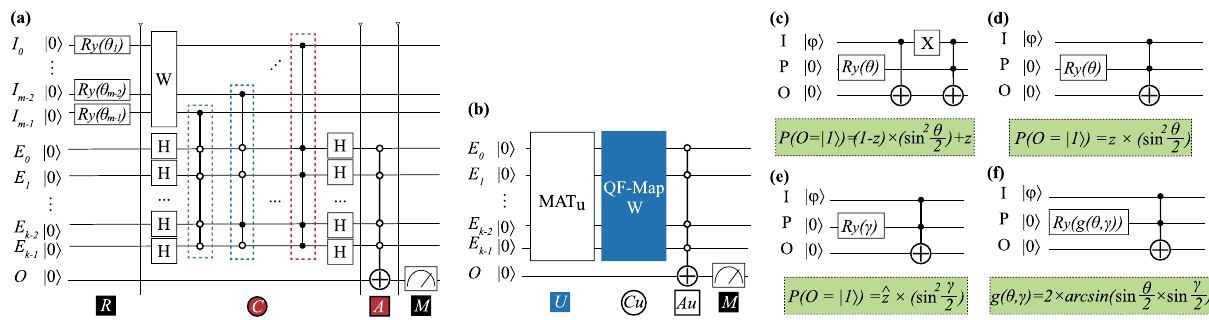
Fig. 6 The corresponding implementation of operations (e.g., R, C, A) in QF-Circ. a Quantum circuit designs for QF-pNet; b quantum circuit design for QF-hNet; c – f batch normalization, quantum circuit designs for different cases; c design of “ batch_adj ” for the case of t = 0; d design of “ batch_adj ” for the case of t = 1; e design of “ indiv_adj ” ; f optimized design for a speci fi c case when t = 1 in “ batch_adj ” .